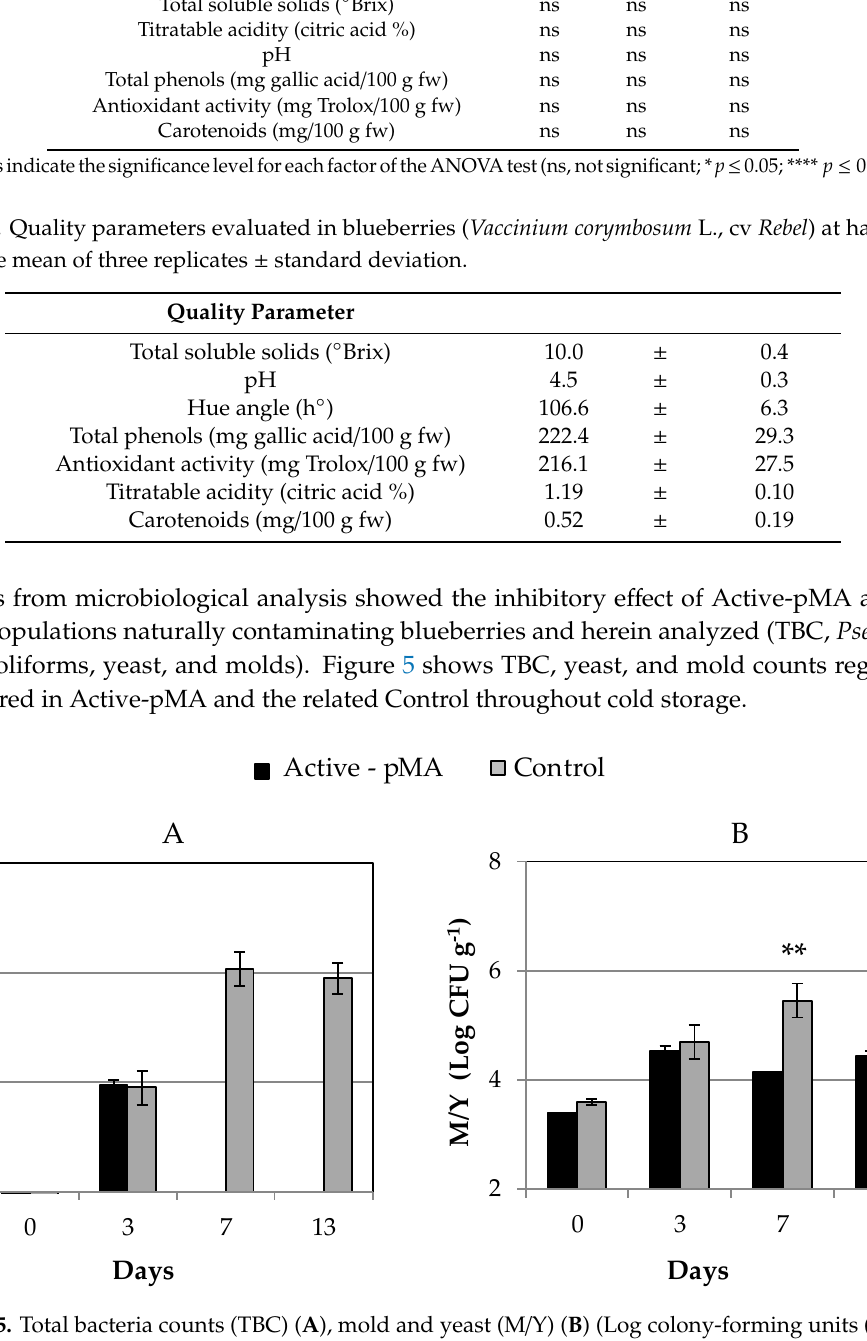
Figure 5. Total bacteria counts (TBC) ( A ), mold and yeast (M / Y) ( B ) (Log colony-forming units (CFU) g − 1) determined in blueberries (cv.Rebel) stored in Active-pMA or in air (Control) for 13 days at 8 °C. Data are mean values ( n = 3) ± standard deviation. Asterisks indicate statistically significance differences (Student’s test, ** p < 0.01 * p < 0.05).